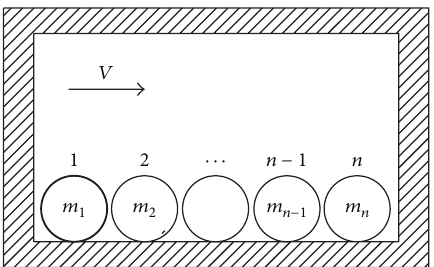
Figure 4: The model after collision with the inner